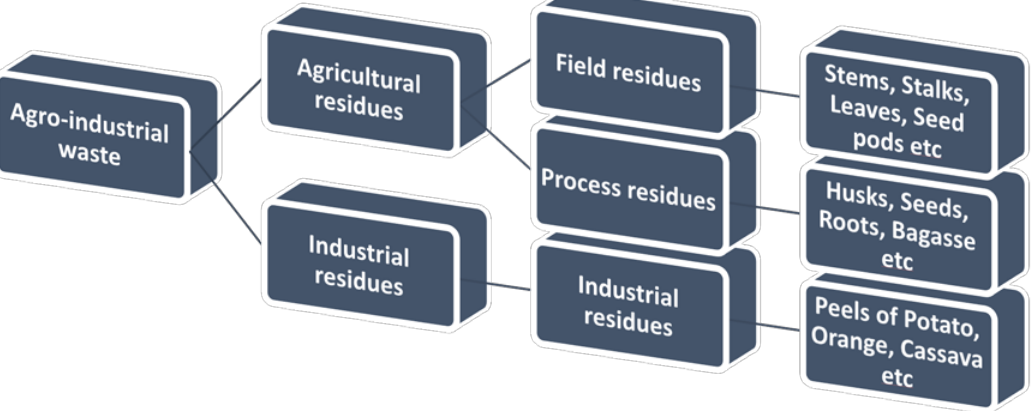
Figure 1. Categorization of agro-industrial waste.